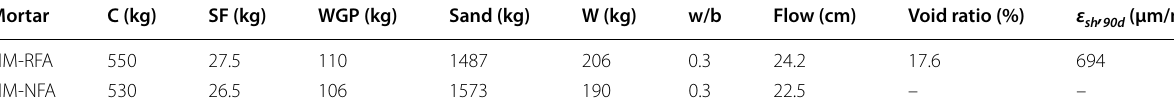
Table 2 Mortar mix design for 1 m 3 and flow, void ratio and shrinkage